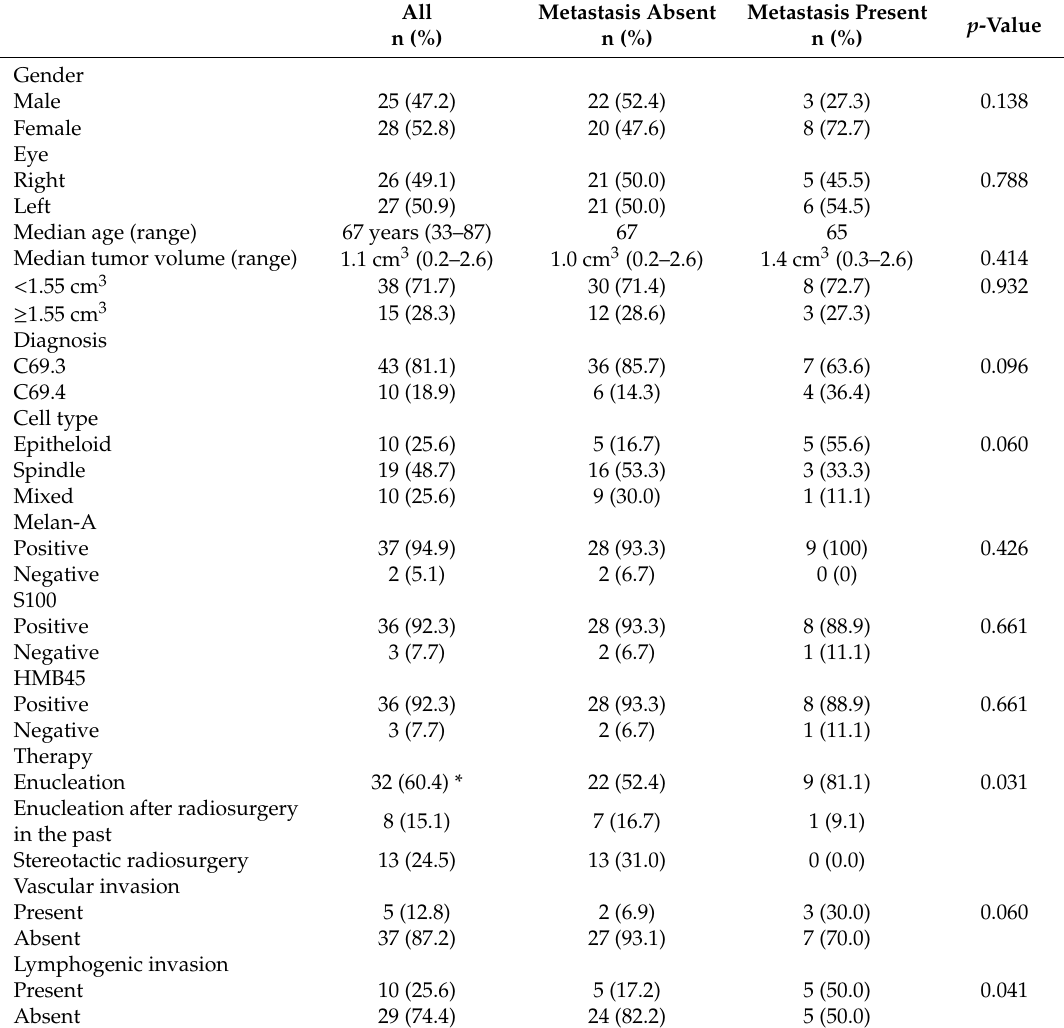
Table 1. Clinico-pathological characteristics of the included